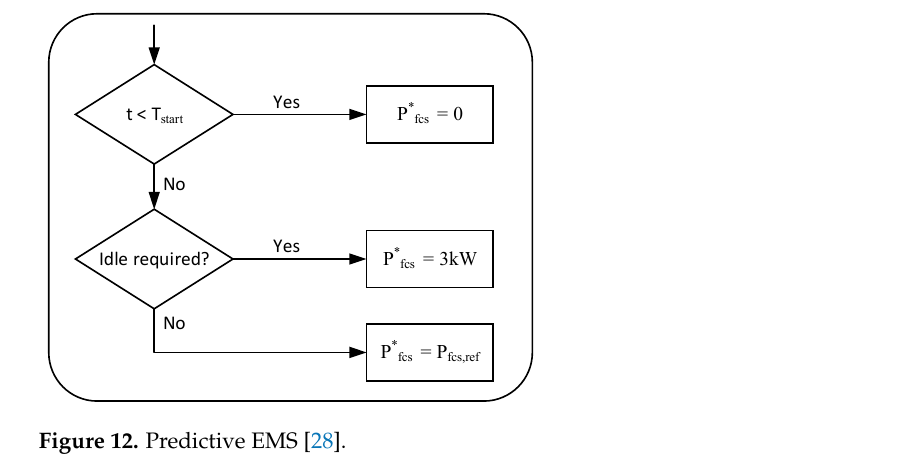
Figure 11. Charge-Balancing EMS [28].